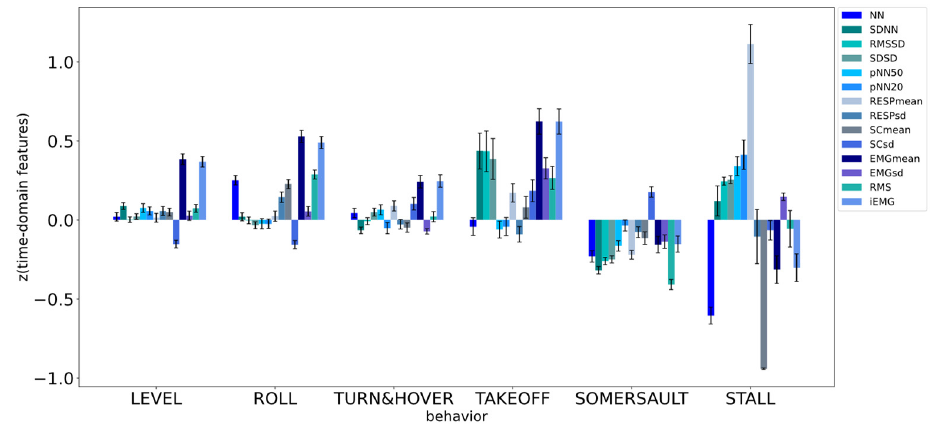
of RESP, the EMG median frequency, and the EMG mean power frequency, as well as raw data, such as ECG, HR, RESP, SC, EMG, and SKT, were recorded according to pilot be- havior and plotted as a trend (Figure 5).